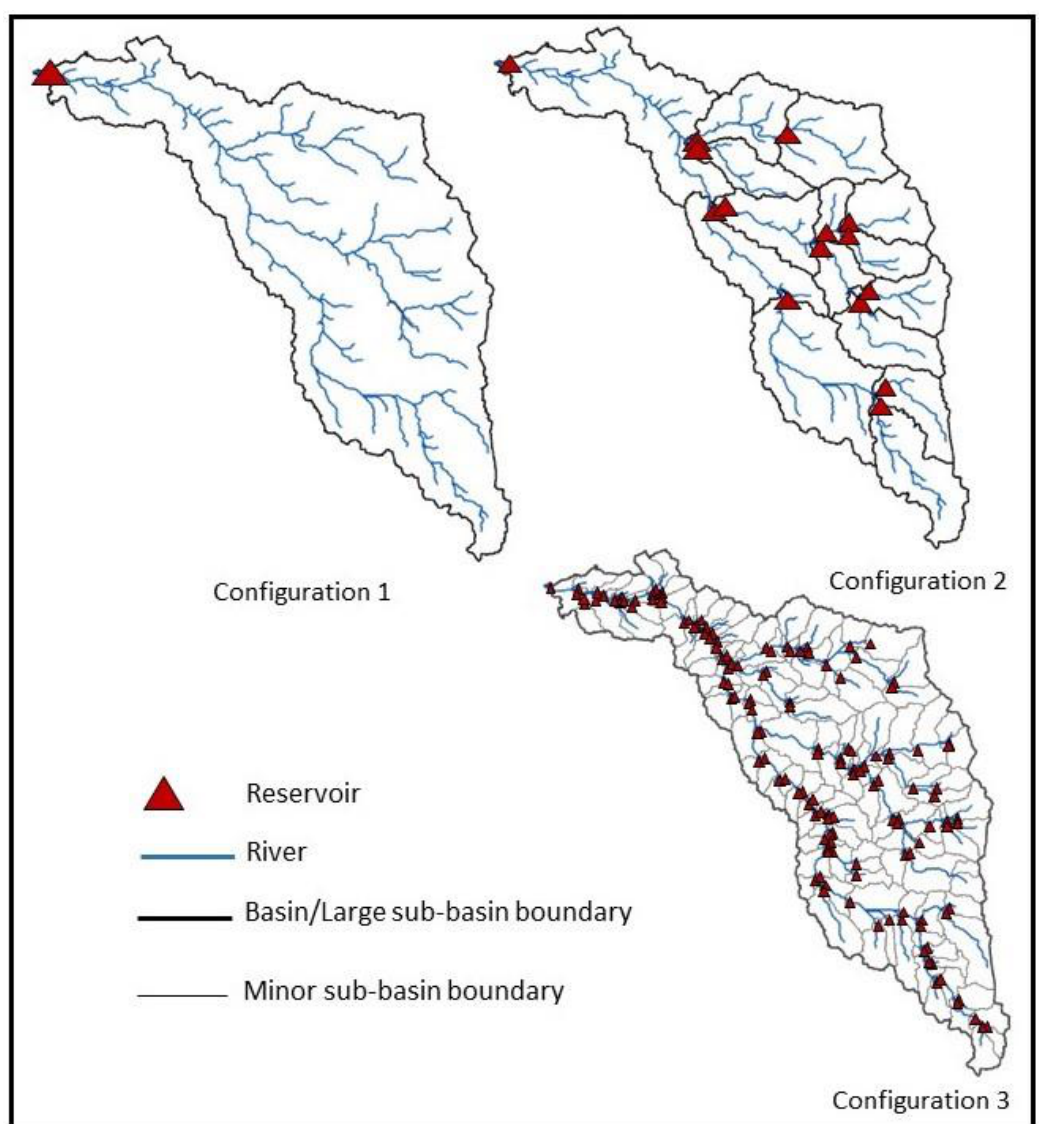
Figure 2. Three reservoir system configurations in Malwatu Oya ranging from one large hypothetical reservoir at the downstream end to 15 medium-size reservoirs in large sub-basins and 148 smaller reservoirs in minor sub-basins.